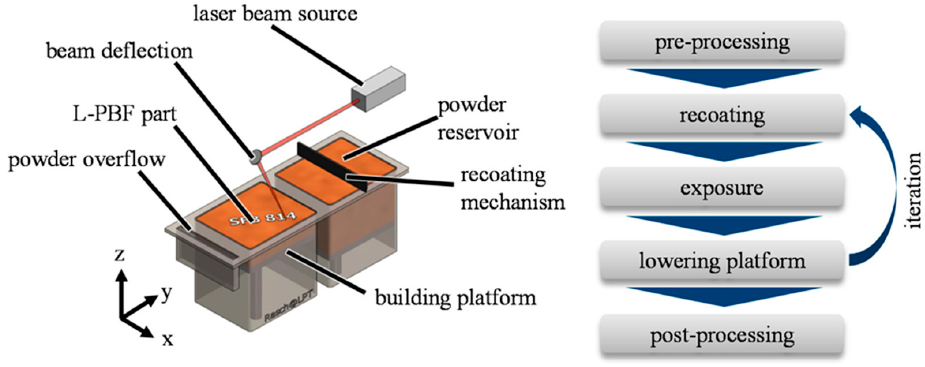
Figure 5. Schematic of the laser powder bed fusion process. Reprinted with permission from Ref.